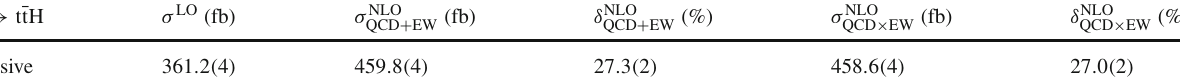
Table 14 Integrated cross sections for pp → t ¯ tH for a centre-of-mass √ s = 13TeV calculated with Sherpa + Recola for the set- energy of up of Ref. [68]. The cross sections at LO as well as for the additive and multiplicative combinations of NLO QCD and EW corrections are